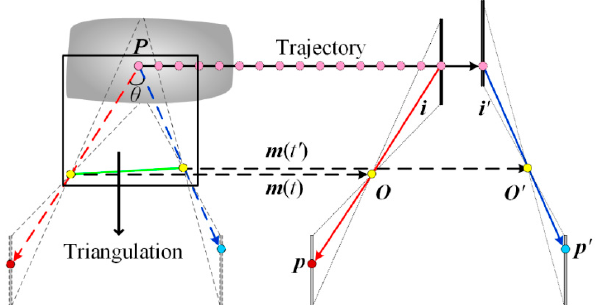
Figure 2. Triangulation of dual line-scan cameras.